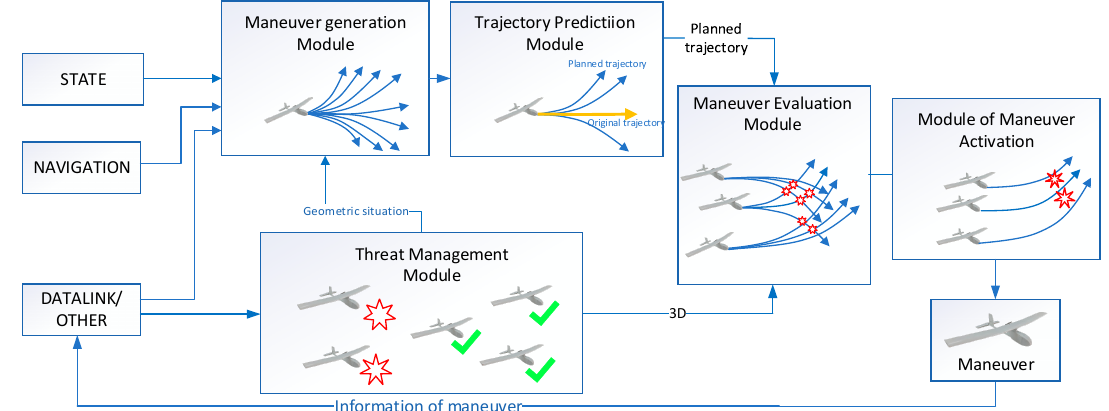
Figure 1. Structure of the algorithm.